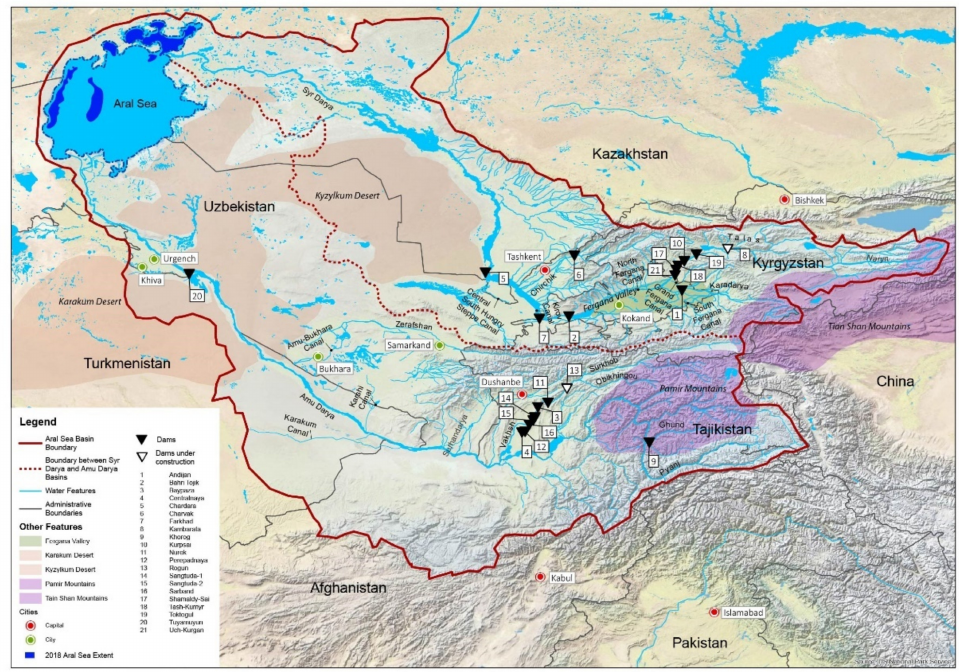
Figure 1. Aral Sea Basin [24]. Reproduced with permission from Hamid Mehmood, Aral Sea Basin book; published by Routledge,